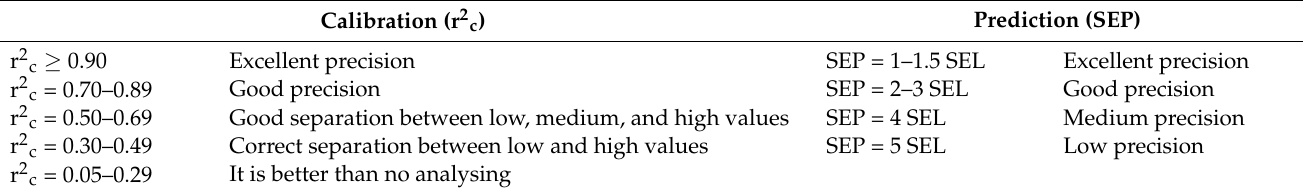
Table 1. Criteria for the assessment of PLS models in NIRS